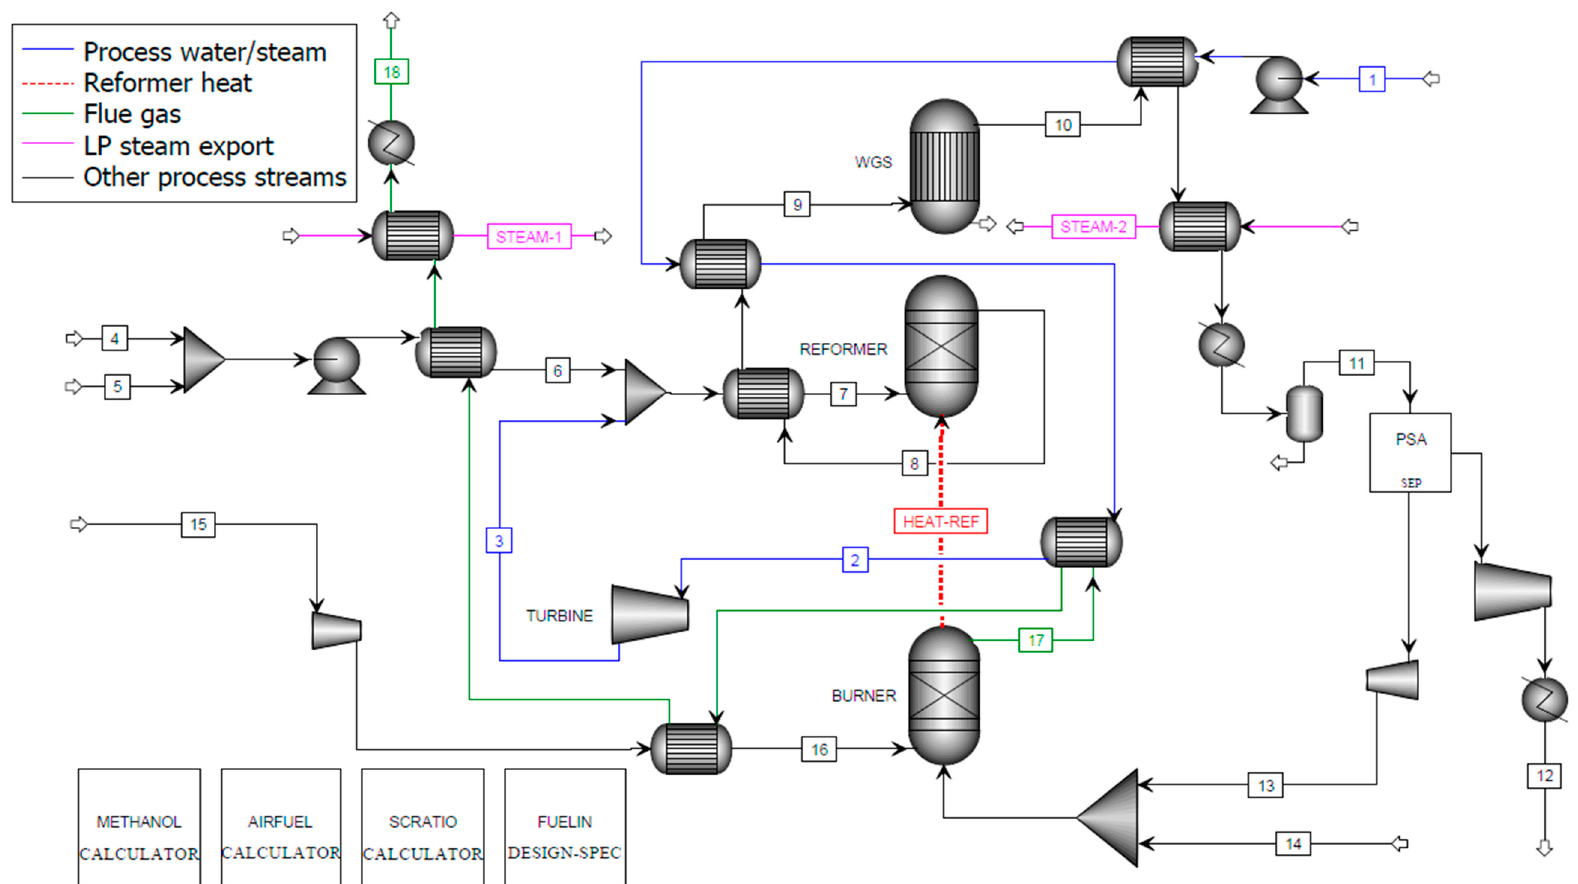
Figure 2. Aspen Plus flowsheet for C-SR of bio-oil without CO 2 capture.